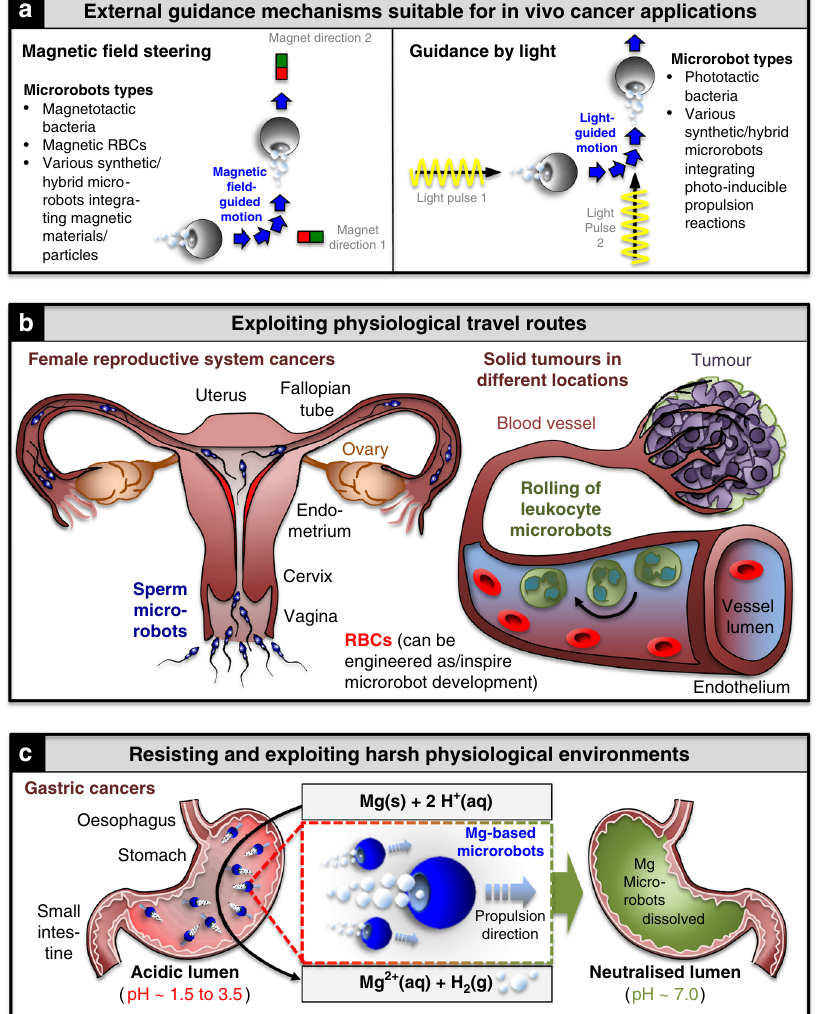
Fig. 4 Microrobot approaches for overcoming long-range tumour-targeting challenges. a Magnetic fi eld (left) and light (right) steering approaches applicable for in vivo applications. b Exploiting physiological travel routes: Left: sperm microrobots in female reproductive tract; tissues relevant for a variety of cancers are highlighted. Right: RBCs and leucocytes travel through vessels that connect and supply tumour tissues. c Resisting and exploiting harsh physiological environments: chemically actuated microrobots have a neutralising effect on the acidic environment inside the stomach lumen. Aq aqueous, g gaseous, RBCs red blood